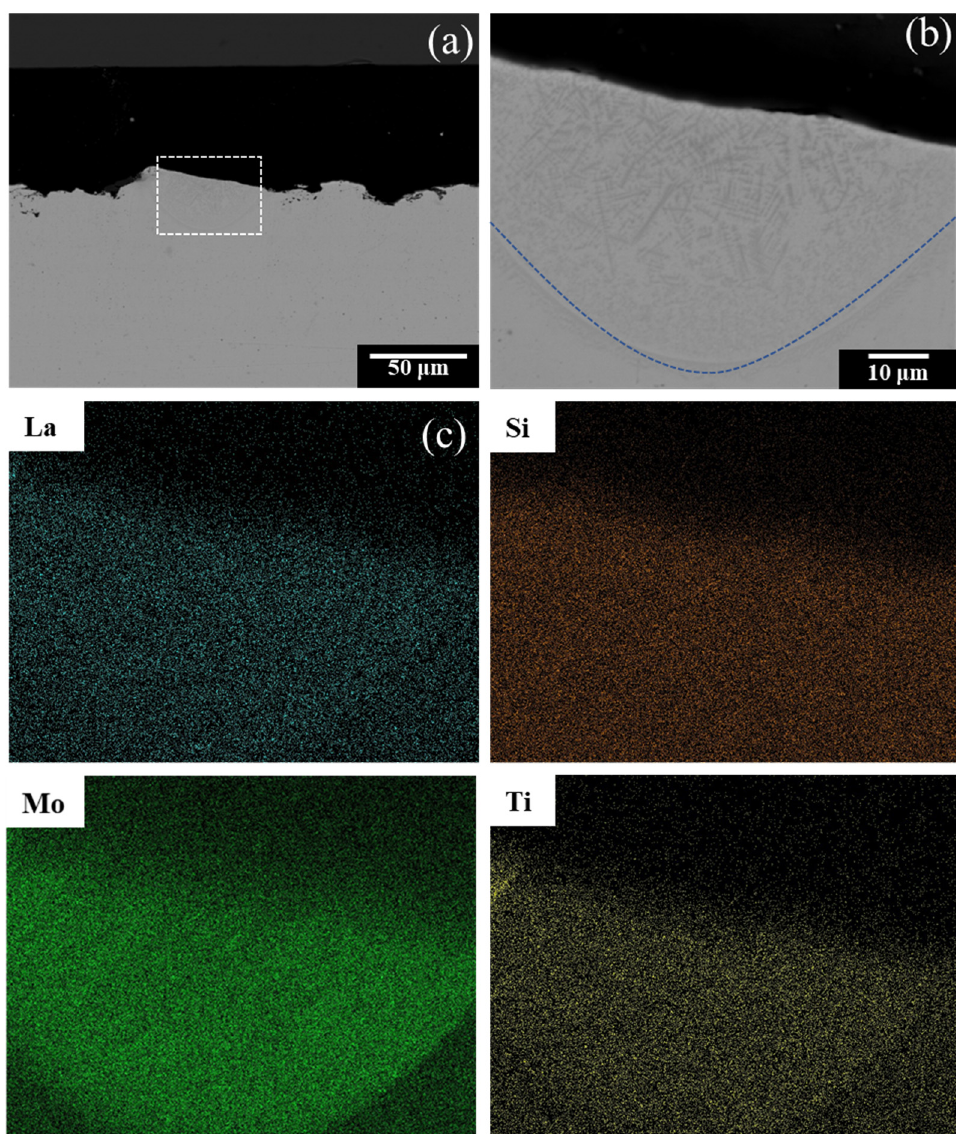
Figure 9. ( a ) Low-magnification SEM image of the cross-section of a molten pool; ( b ) high-magnification SEM image and ( c ) corresponding EDS mappings taken from the white square in ( a ).